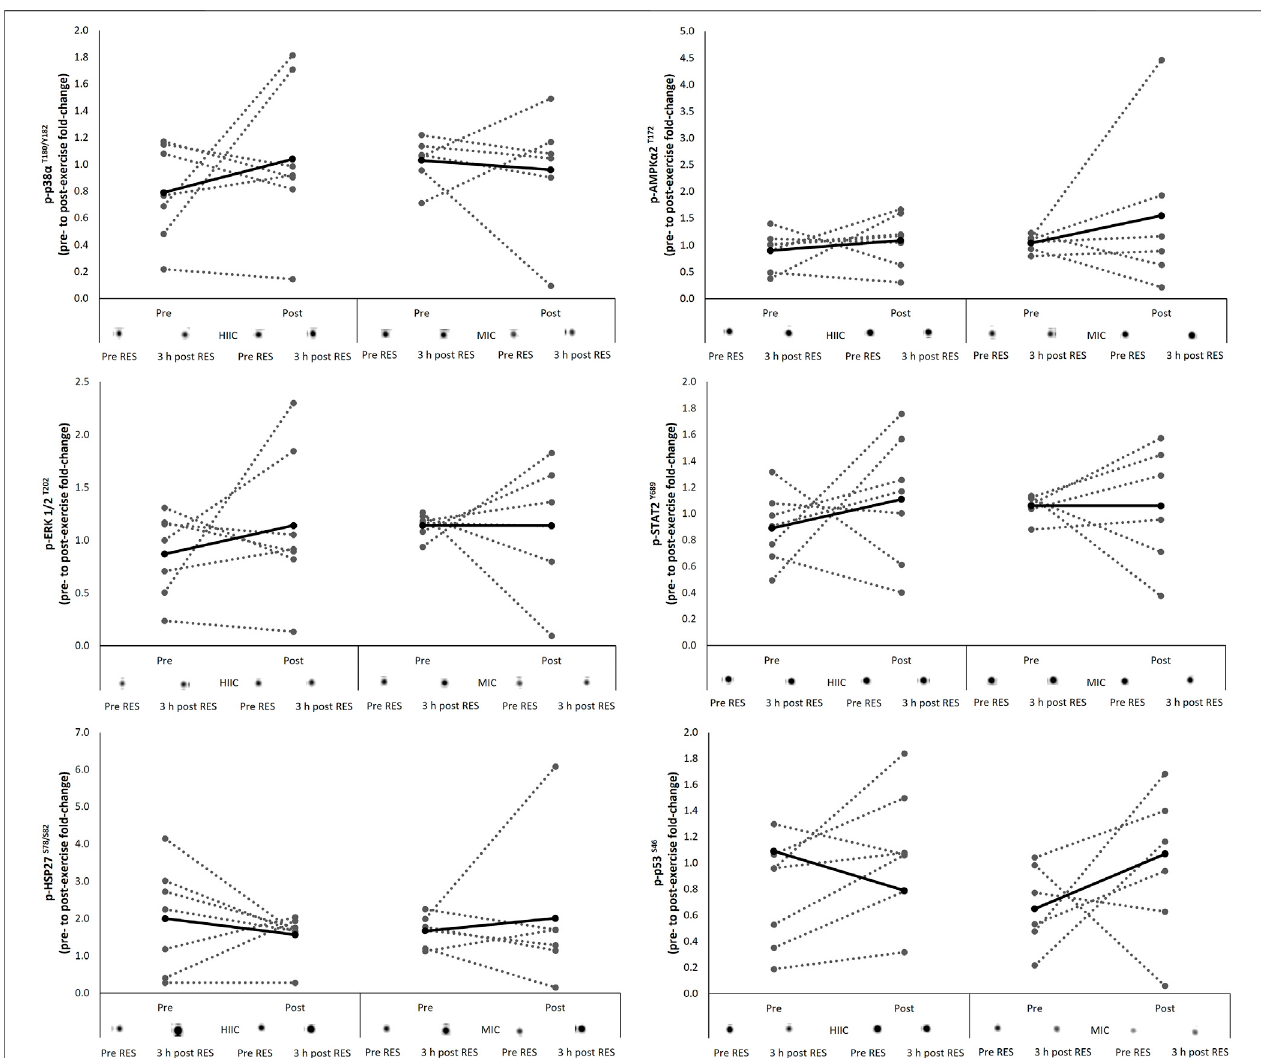
FIGURE 4 | Individual (dashed lines and grey dots) and mean (black lines and black dots) 5-RM (A) back-squat (B) split-squat performance and (C) calf-raise performance(%changefrombaseline)acrosstheinterventionperiodintheMICT( n =6)andHIIT( n =7)groups.Absolutebaselinevaluesforback-squat,split-squatand calf-raise were; 89.2 ± 14.6 and 95.4 ± 22.7 kg, 51.7 ± 9.3 and 56.1 ± 7.9 kg, 83.3 ± 14.0 and 102.1 ± 9.9 kg for MICT and HIIT, respectively. *, signi fi cantly different from session 1 ( p < 0.001). MICT = moderate intensity continuous training; HIIT = high intensity interval training.